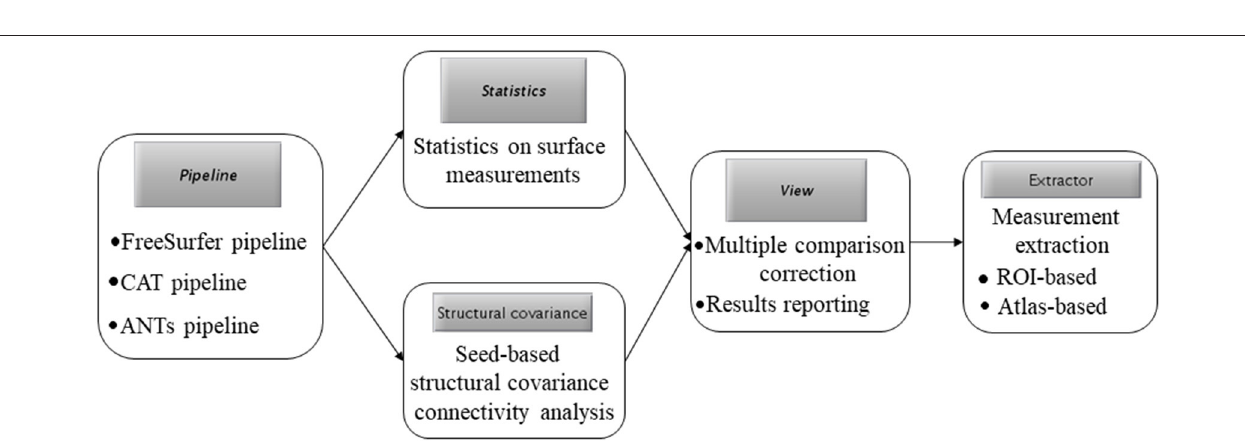
FIGURE 2 | The flow chart of